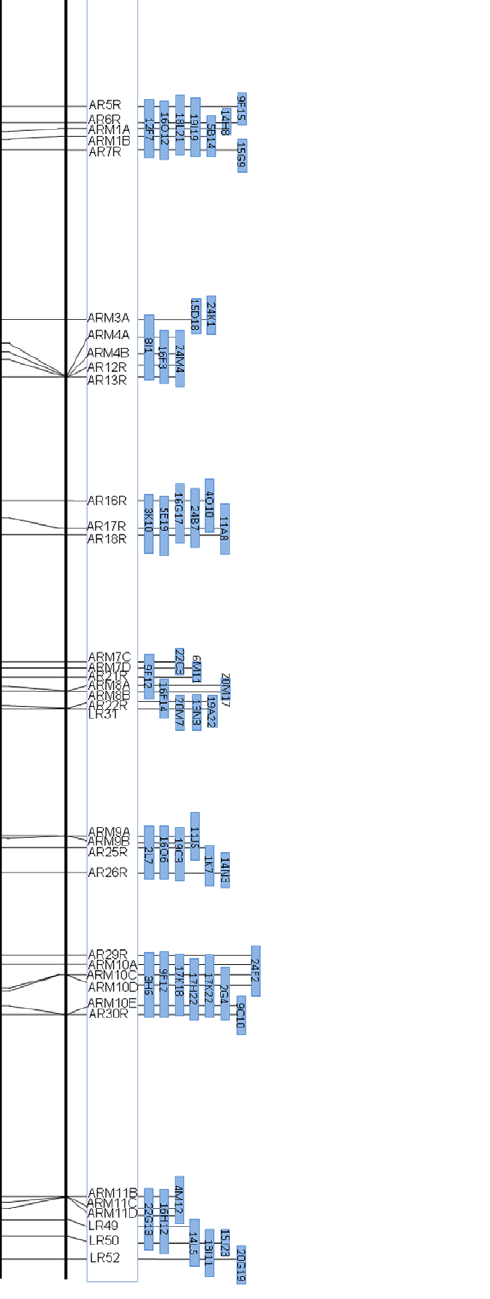
Figure 3. The physical map of FCA locus in comparison to its sequence. The sequence position indicated by the first nucleotide of the 40 markers belonging to the FCA locus (a) is reflected by the physical map (b – enframed and c) after BAP mapping. With the BAC range panel, the BACs (blue rectangles) harbouring the 40 markers are sorted into 8 contigs (c) and assembled by means of the long-range panel into a single linkage map (b) spanning the entire region of 1.8 Mbp.